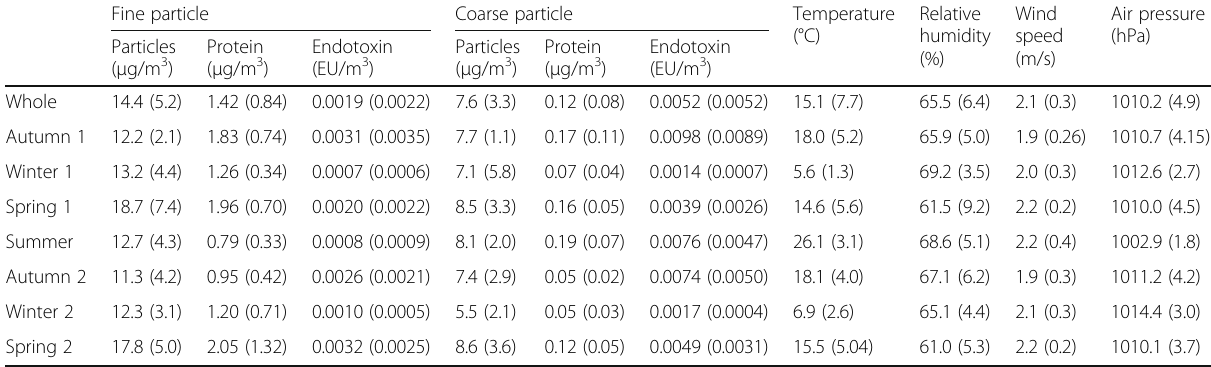
Table 2 Weekly mean value (standard deviation) of air pollutants and meteorological factors Fine particle Coarse particle